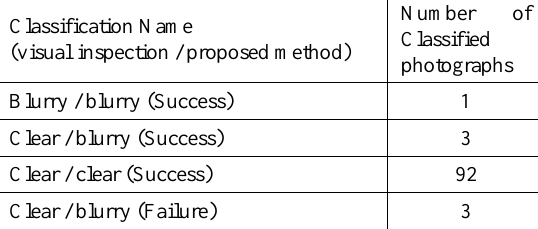
Table 2. Number of classified photographs by